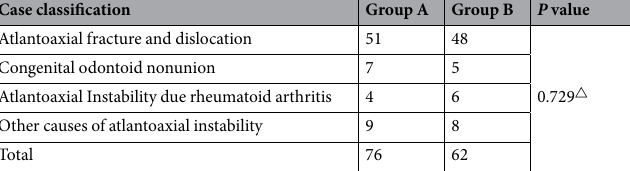
Table 1. The case classification of two groups. △ P > 0.05 compared to the data of Group A.